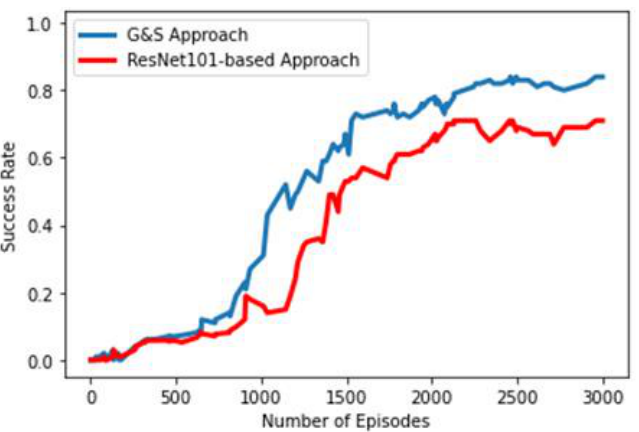
Figure 13. Performance comparison of original G&S approach and ResNet-based approach.